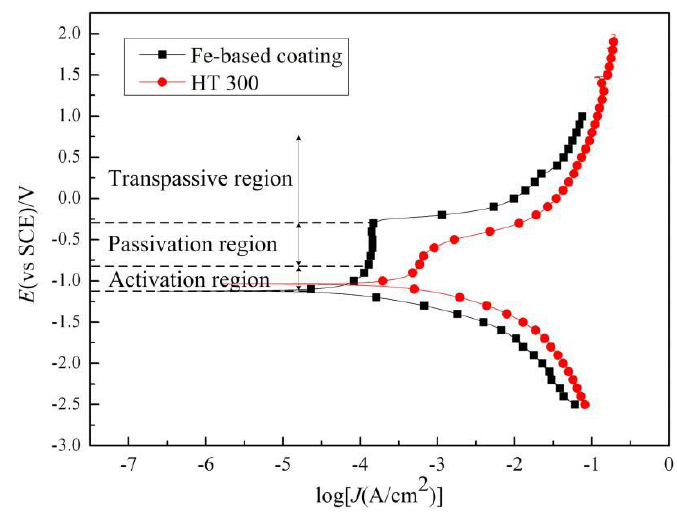
Figure 10. Polarization curves of Fe-based coating and HT 300 in 3.5% NaCl solution.